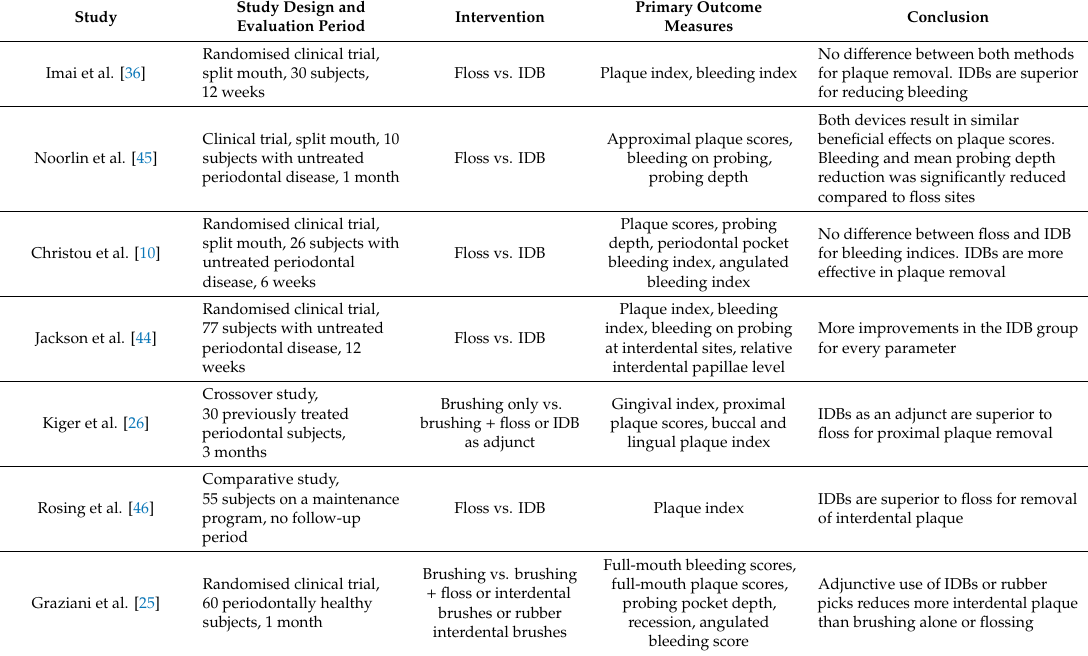
Table 2. Summary of included studies on the e ff ectiveness of interdental brushes and